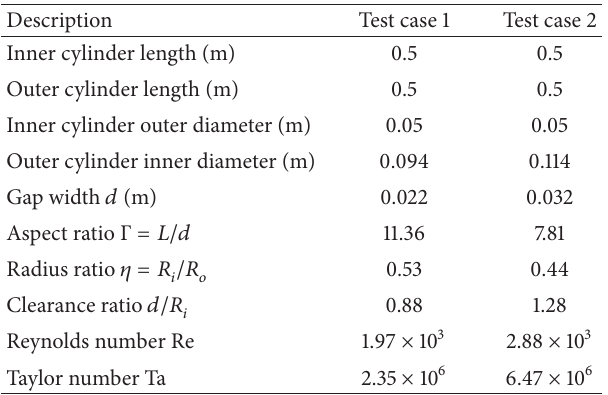
Table 1: Specifications for the computational